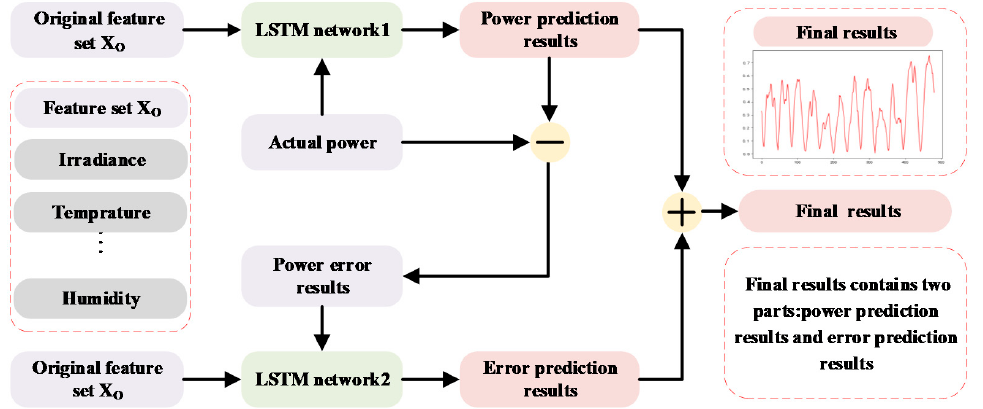
Figure 2. The structure of BC–LSTM: purple boxes represent input, green boxes represent neural networks, red boxes represent output, and gray boxes represent the features.